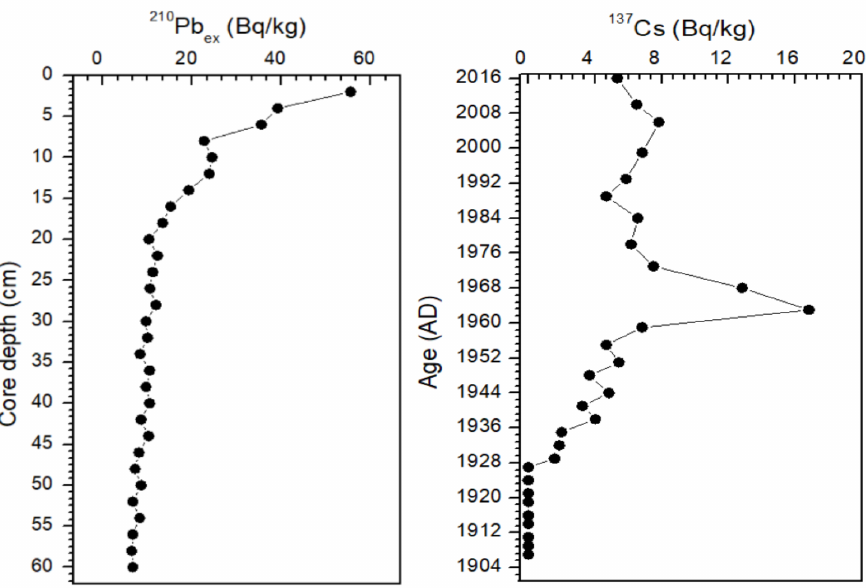
Figure 2. Age–depth profiles of excess 210 Pb ( 210 Pb ex ) and 137 Cs in the sediment